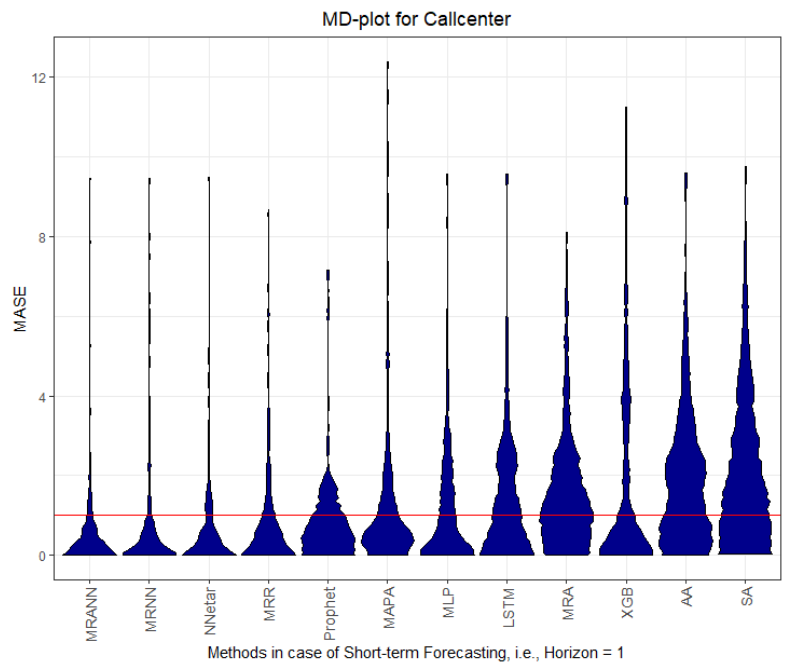
Figure 1. Mirrored density plot of Mean Absolute Scaled Errors (MASE) computed with a rolling forecasting origin for horizon 1 on dataset